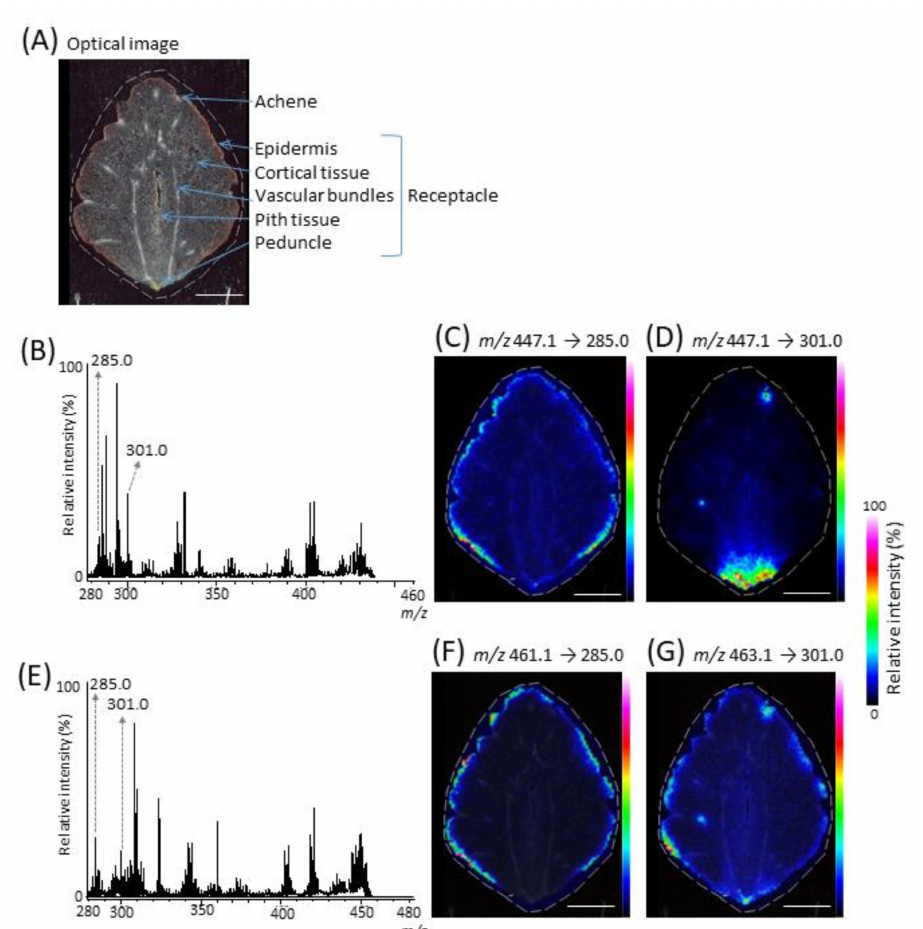
Figure 3. Matrix-assisted laser desorption / ionization (MALDI)-tandem mass spectrometry